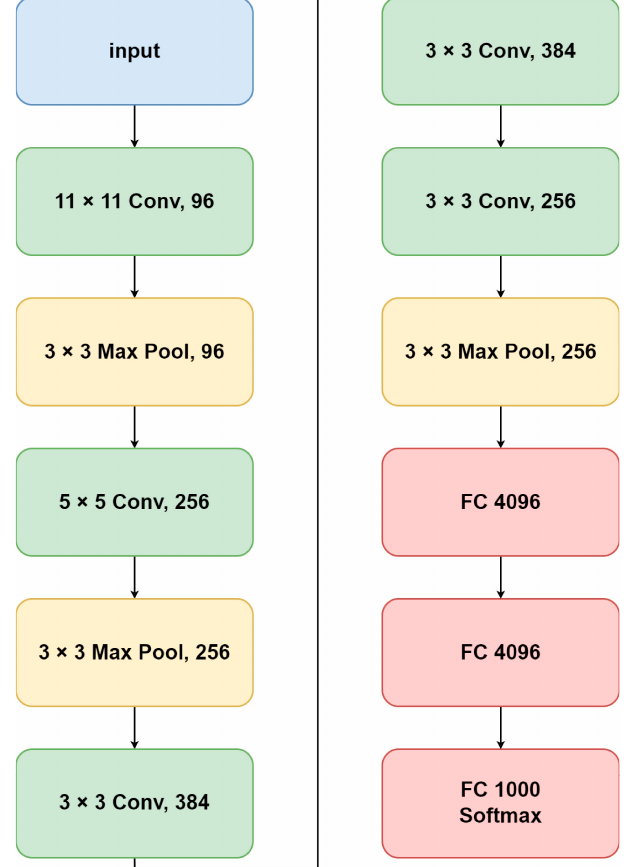
Figure 5. AlexNet architecture.